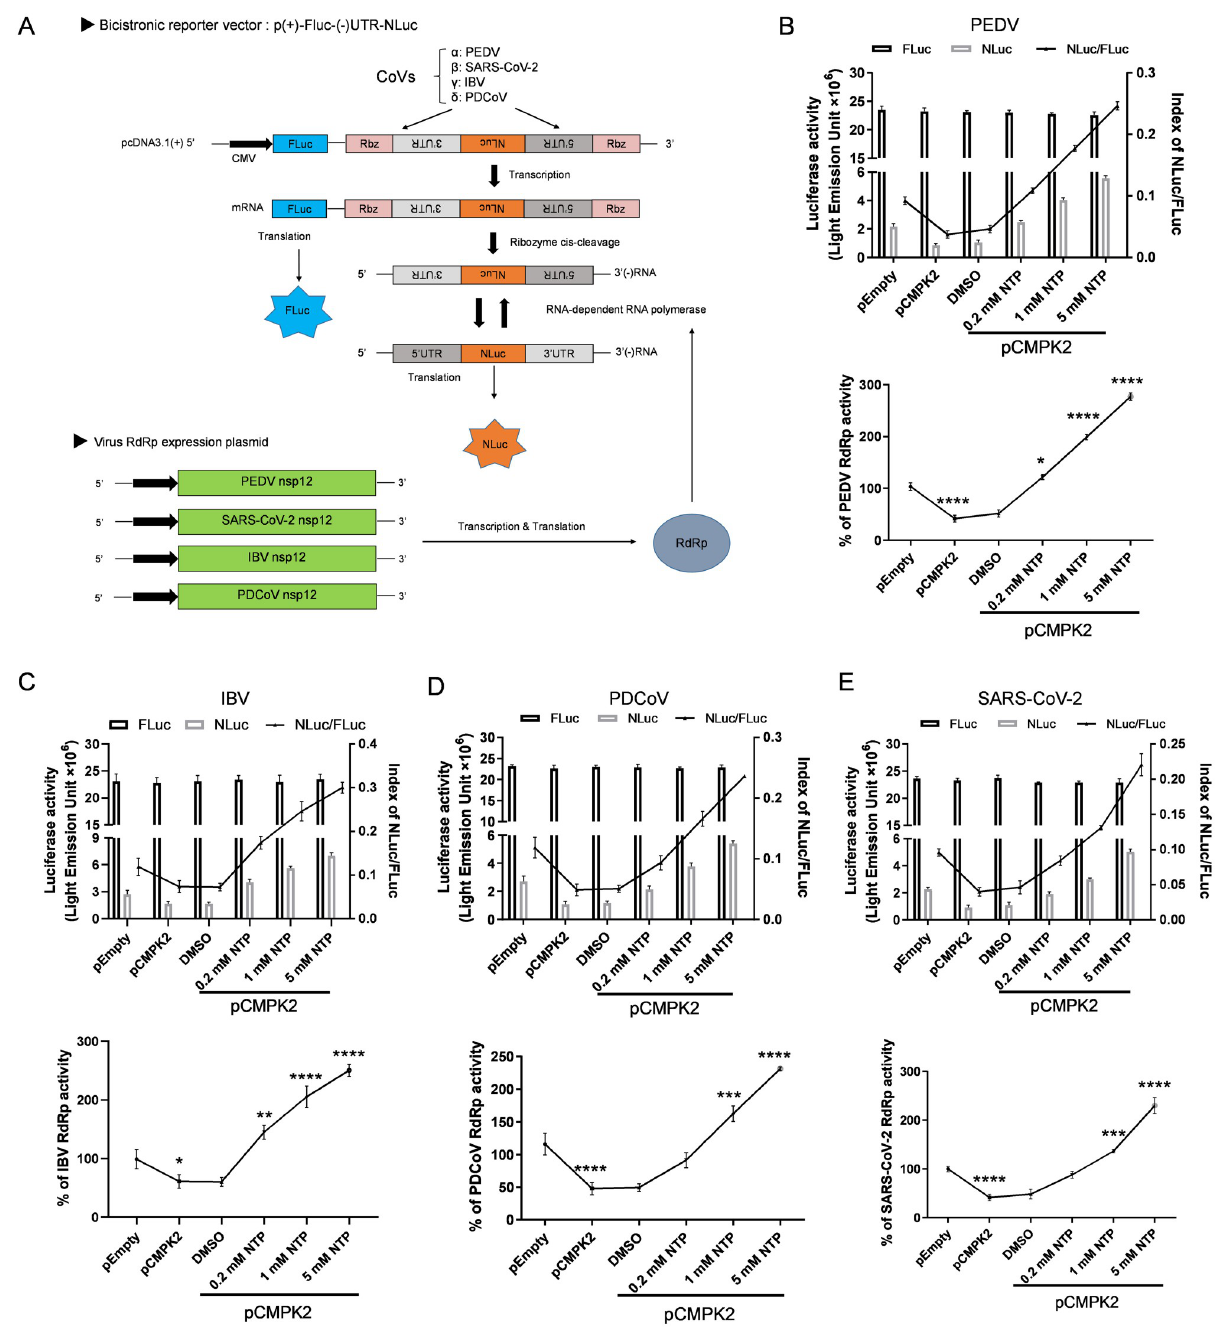
Fig 7. CMPK2 inhibits the RdRp activity of multiple CoVs. (A) Schematic diagram of the cell-based reporter assay system for CoV RdRp activity. (B) HEK293T cells were transfected with empty vector and pCMPK2 and then treated with different concentrations of NTP. Effects of CMPK2 on PEDV RdRp activity were detected by the cell-based reporter assay system. (C-E) HEK293T cells were handled like ( B ) and the effects of CMPK2 on IBV ( C ), PDCoV ( D ), and SARS-CoV-2 ( E) RdRp activity were, respectively, detected by the cell-based reporter assay system. Data are means ± SD of triplicate samples; statistical analysis was conducted using two-tailed Student t test; only the p -value for the most relevant comparisons are shown for simplicity. � p < 0.05, �� p < 0.01, ��� p < 0.001, ���� p < 0.0001. Data underlying this figure can be found in S1 Data. CMPK2, cytidine/uridine monophosphate kinase 2; CoV, coronavirus; IBV, infectious bronchitis virus; NTP, nucleotide triphosphate; PDCoV, porcine delta-coronavirus; PEDV, porcine epidemic diarrhea virus; RdRp, RNA-dependent RNA polymerase; SARS-CoV-2, Severe Acute Respiratory Syndrome Coronavirus 2.